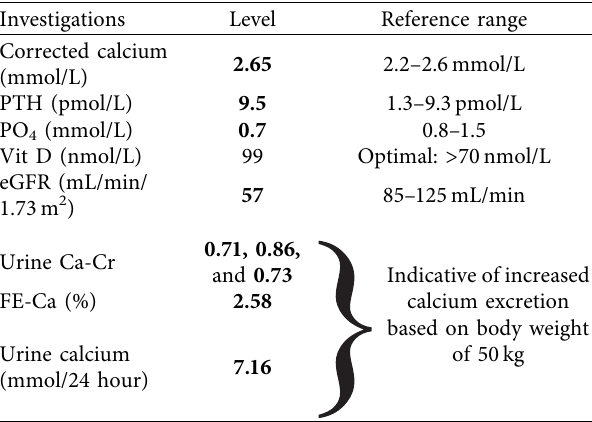
Table 1: Laboratory results.